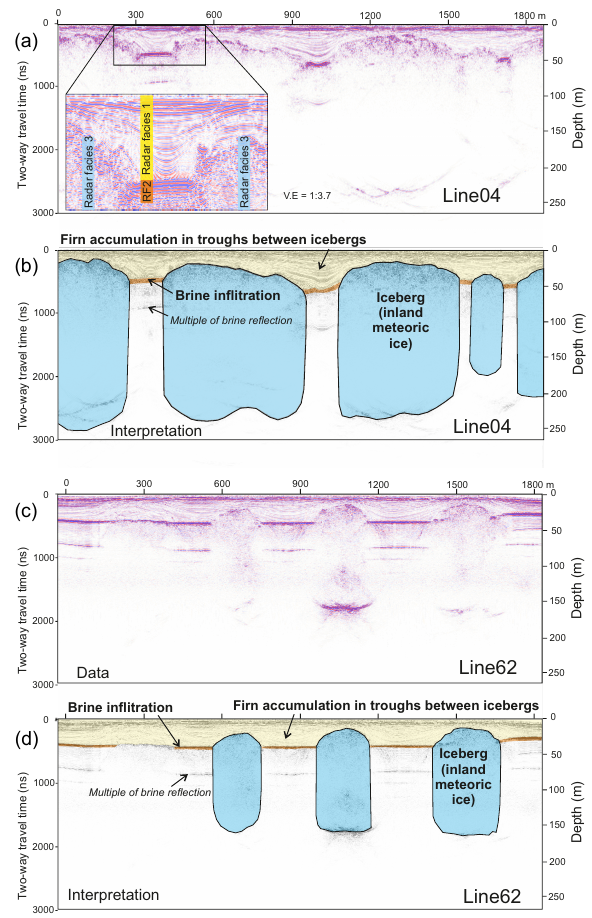
Figure 4. Ice shelf cross sections acquired with a 50MHz ground- penetrating radar system. Locations are marked in Fig. 2. Radar fa- cies descriptions and interpretations are given in the text. (a) Line 04 lies along one of the “railway tracks”. Three radar facies are identified (inset). (b) Interpretation of line 04. Radar facies 1 is in- terpreted as firn accumulated by snow fall and drift on the ice shelf. Radar facies 2 is interpreted as a brine horizon. Radar facies 3 is in- terpreted as blocks of meteoric ice that originate as icebergs calved off the inland ice sheet at the grounding line; the blocks are up to 200m thick. (c, d) Radar cross section from line 62 in the thinner ice shelf area between two of the “railway tracks”. The icebergs are significantly thinner and more widely